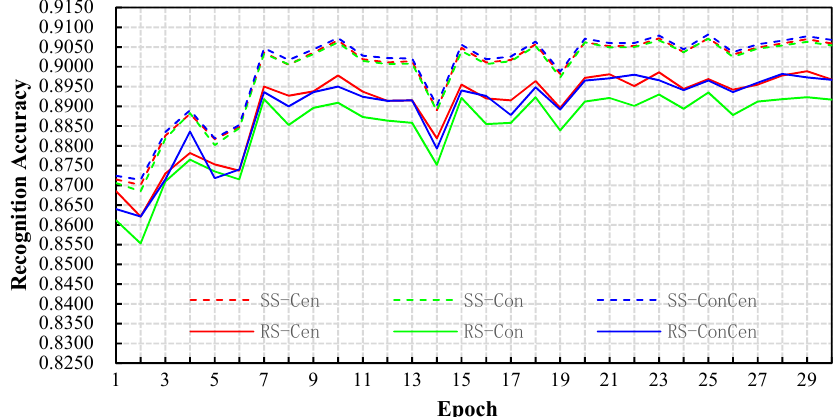
Figure 12. Recognition result statistics of correct character segmentation.